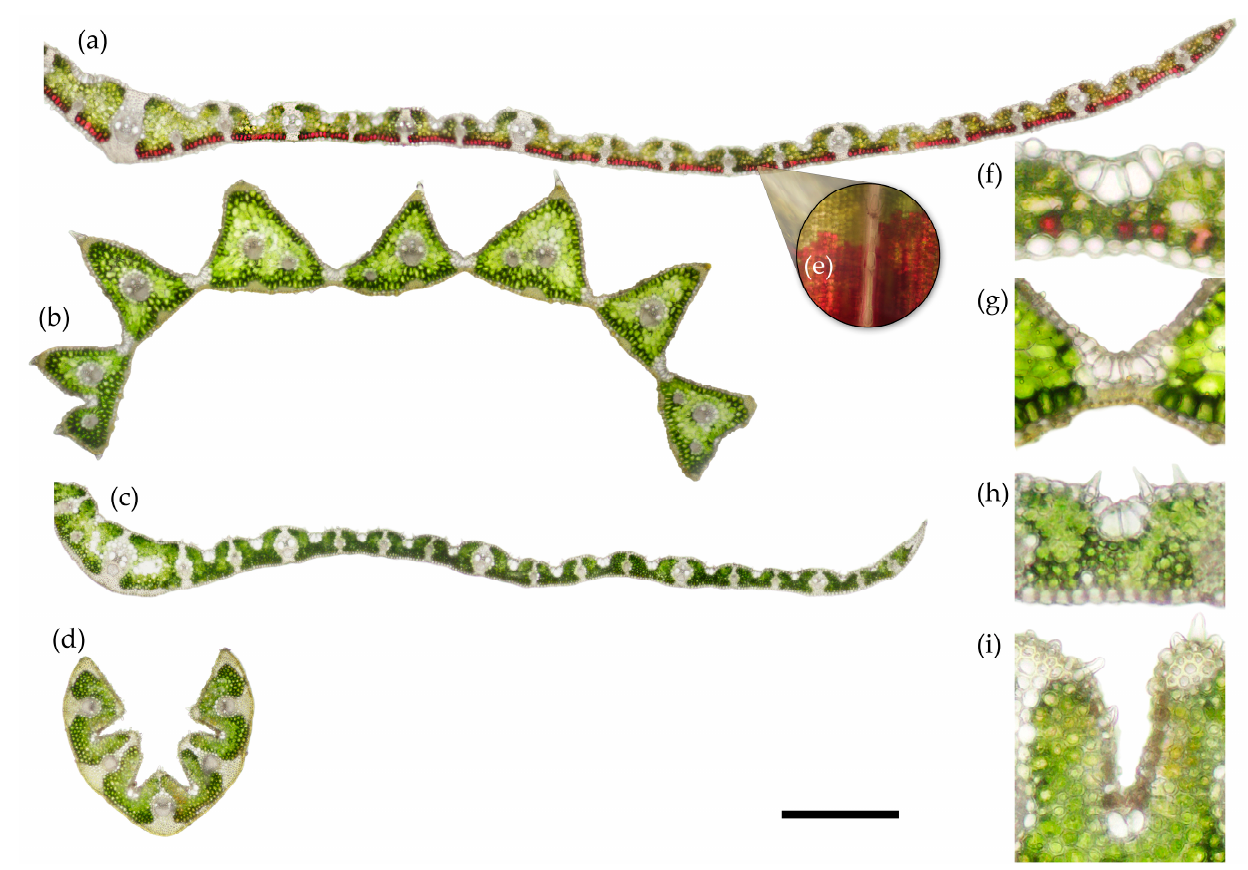
Figure 2. Representative unstained cross-sections of a fully developed leaf from each of the four competing grass species. The section was taken from the central part of the leaf blade in August 2020. Fresh hand sections, 70–80 µm thick, imaged at 10× magnification, bright field; the green color corresponds to mesophyll cells with chlorophyll, while the red color corresponds to vacuolar anthocyanins in mesophyll cells adjacent to abaxial epidermis. Calamagrostis villosa (half leaf) ( a ), Deschampsia cespitosa ( b ), Molinia caerulea (half leaf) ( c ), and Nardus stricta ( d ). The scale bar is equal to 0.5 mm. Detail of the anthocyanins in the abaxial mesophyll layer of Calamagrostis villosa shown in paradermal view at 10 × magnification ( e ). Bulliform cells of each species: C. villosa ( f ), D. cespitosa ( g ), M. caerulea ( h ), and N. stricta ( i